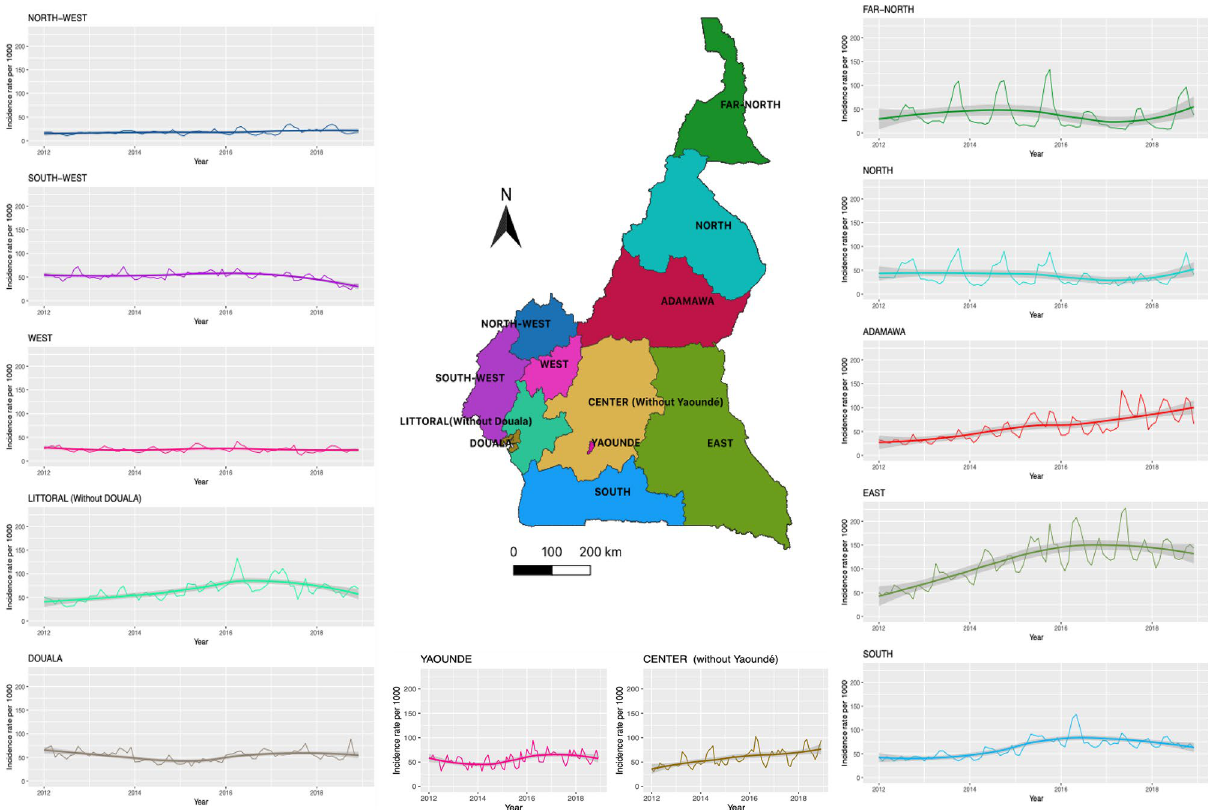
Figure 1. Malaria incidence rate in under-fives by region between 2012–2018. Each panel represents the trend in U-5 malaria incidence in one of the country’s regions between the years 2012 and 2018. The two largest cities in the country (Douala and Yaoundé) are shown separately, outside the regions where they are located. The names of the regions are mentioned at the top of each panel and the map in the middle gives the geographical location of each region. The map was generated with QGIS version 3.4.8 (URL: https:// qgis. org/ en/ site), and the graphics with the ggplot2 package of R software version 4.0.2 (URL: https:// cran.r- proje ct. org/ web/ packa ges/ ggplo t2/ index.